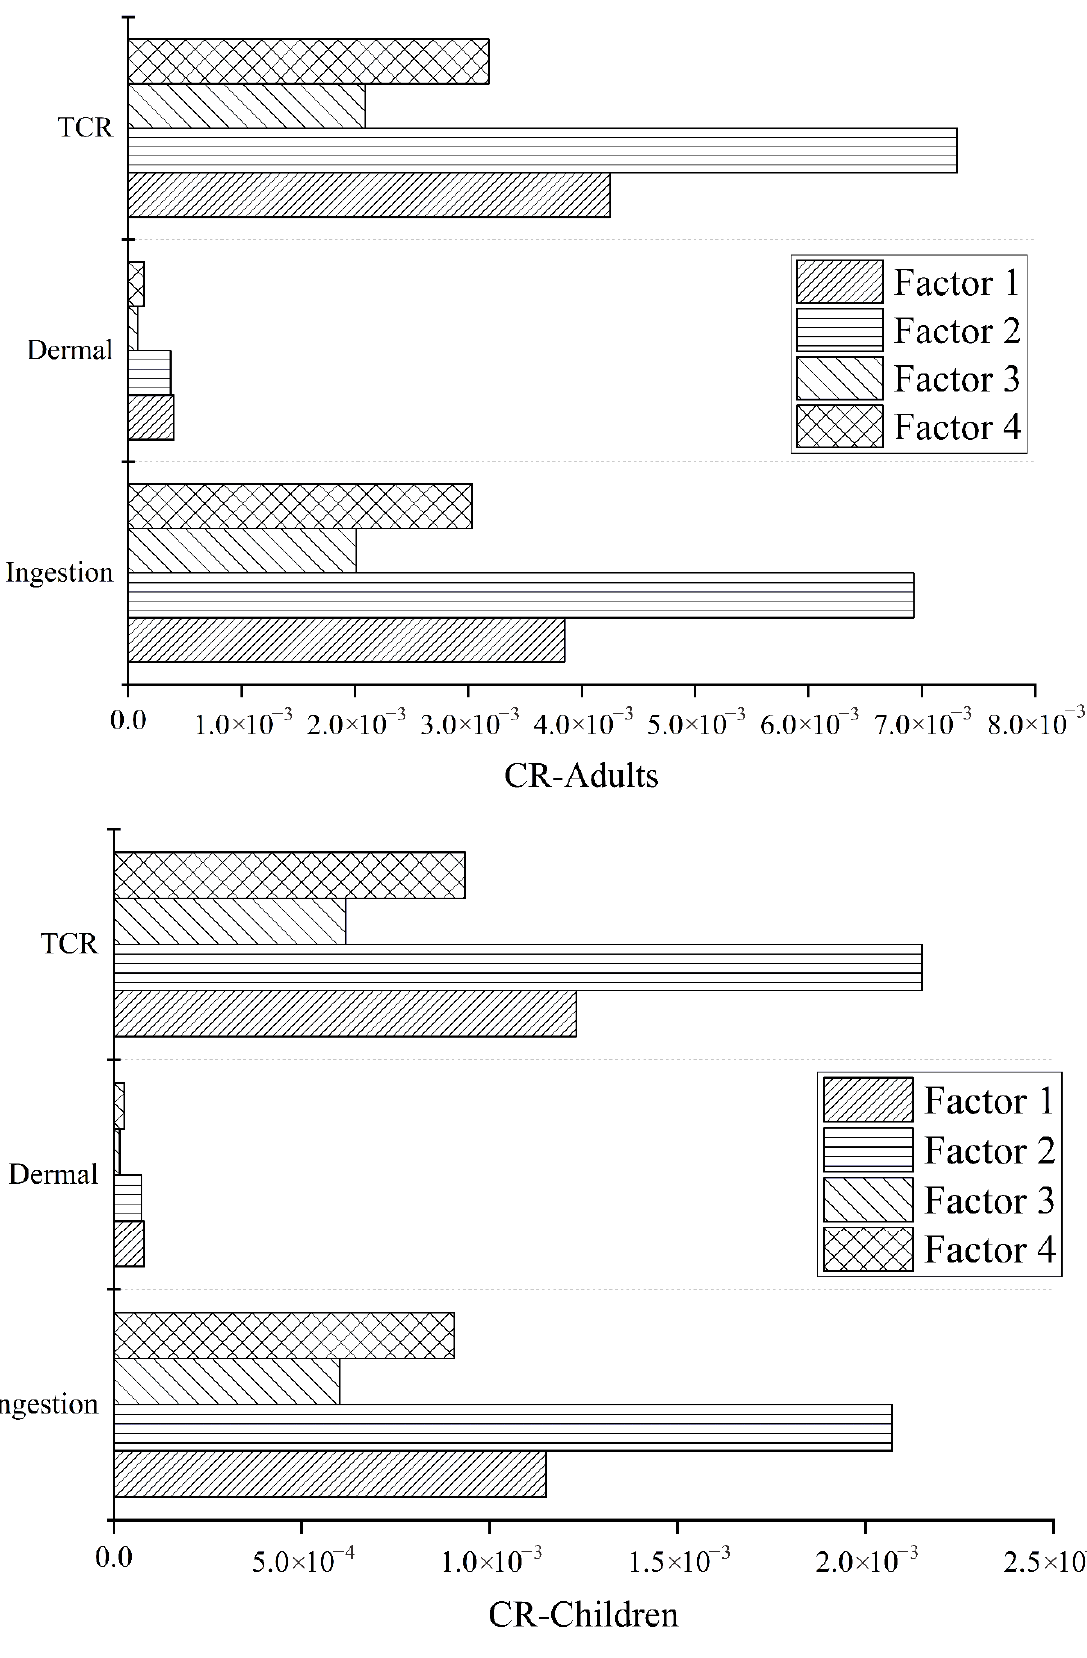
Figure 9. HI and CR values for adults and children.